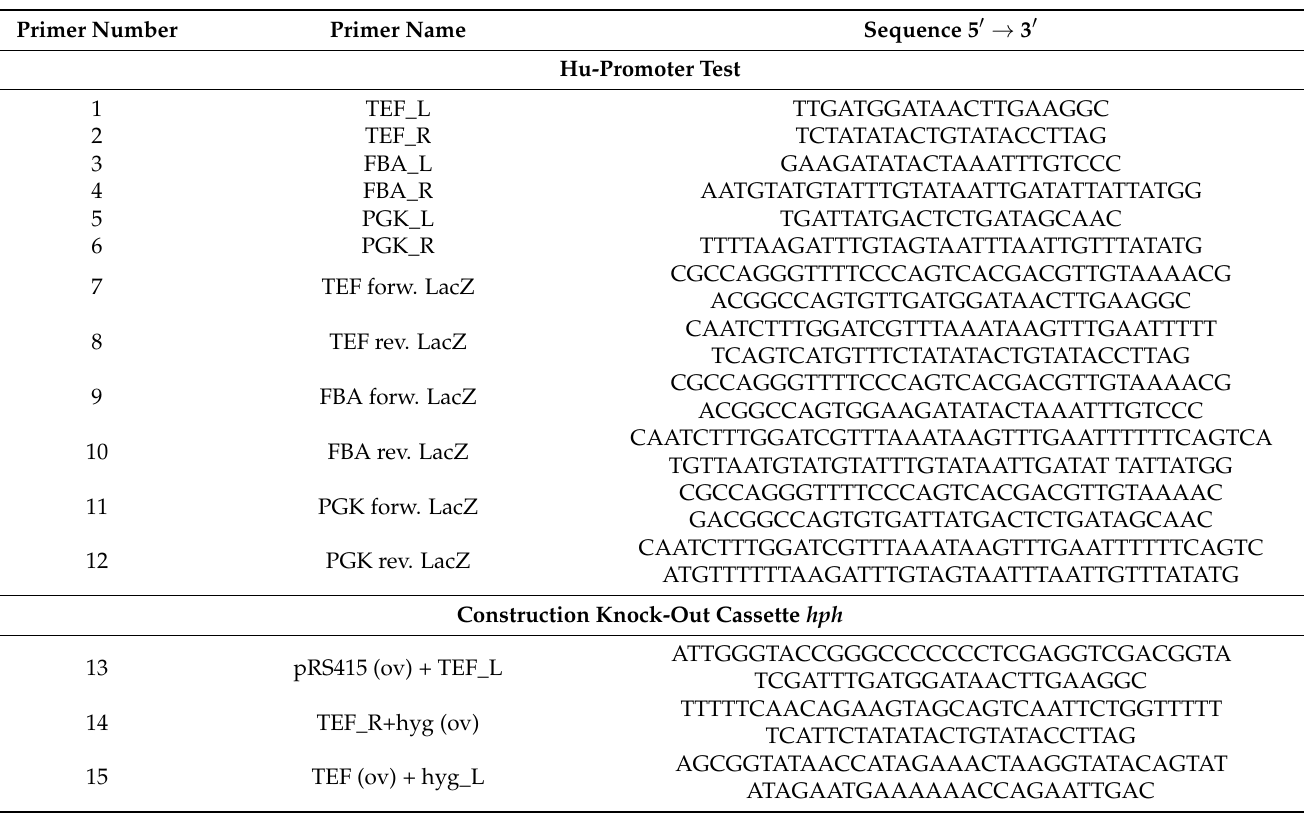
Table 3. Primers used in this